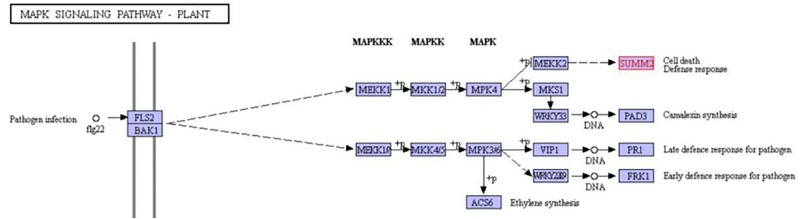
Part of the plant MAPK signaling pathway. The location of gene SUMM2 is labeled in red block (Kanehisa and Goto, 2000).